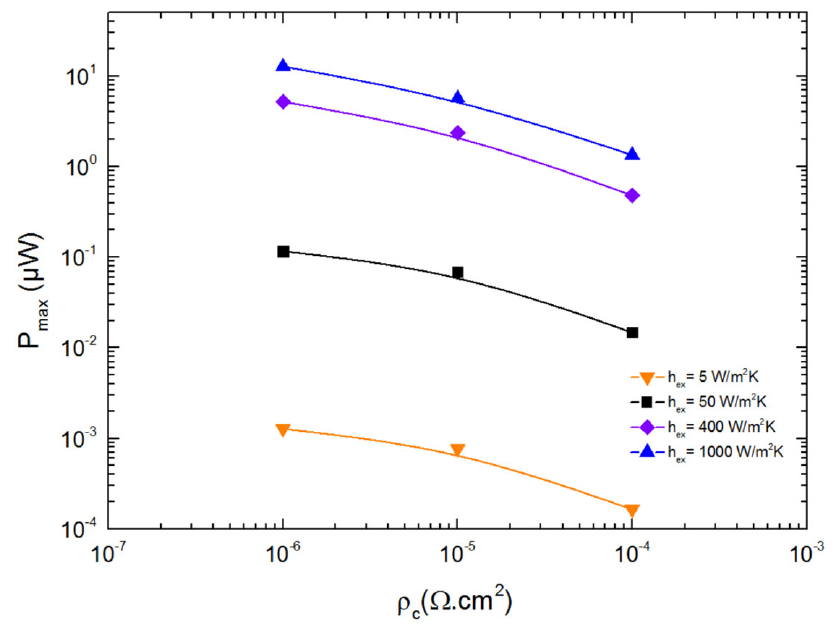
Figure 5. Maximal output power P max as a function of ρ c for different values of the heat exchange coefficient.